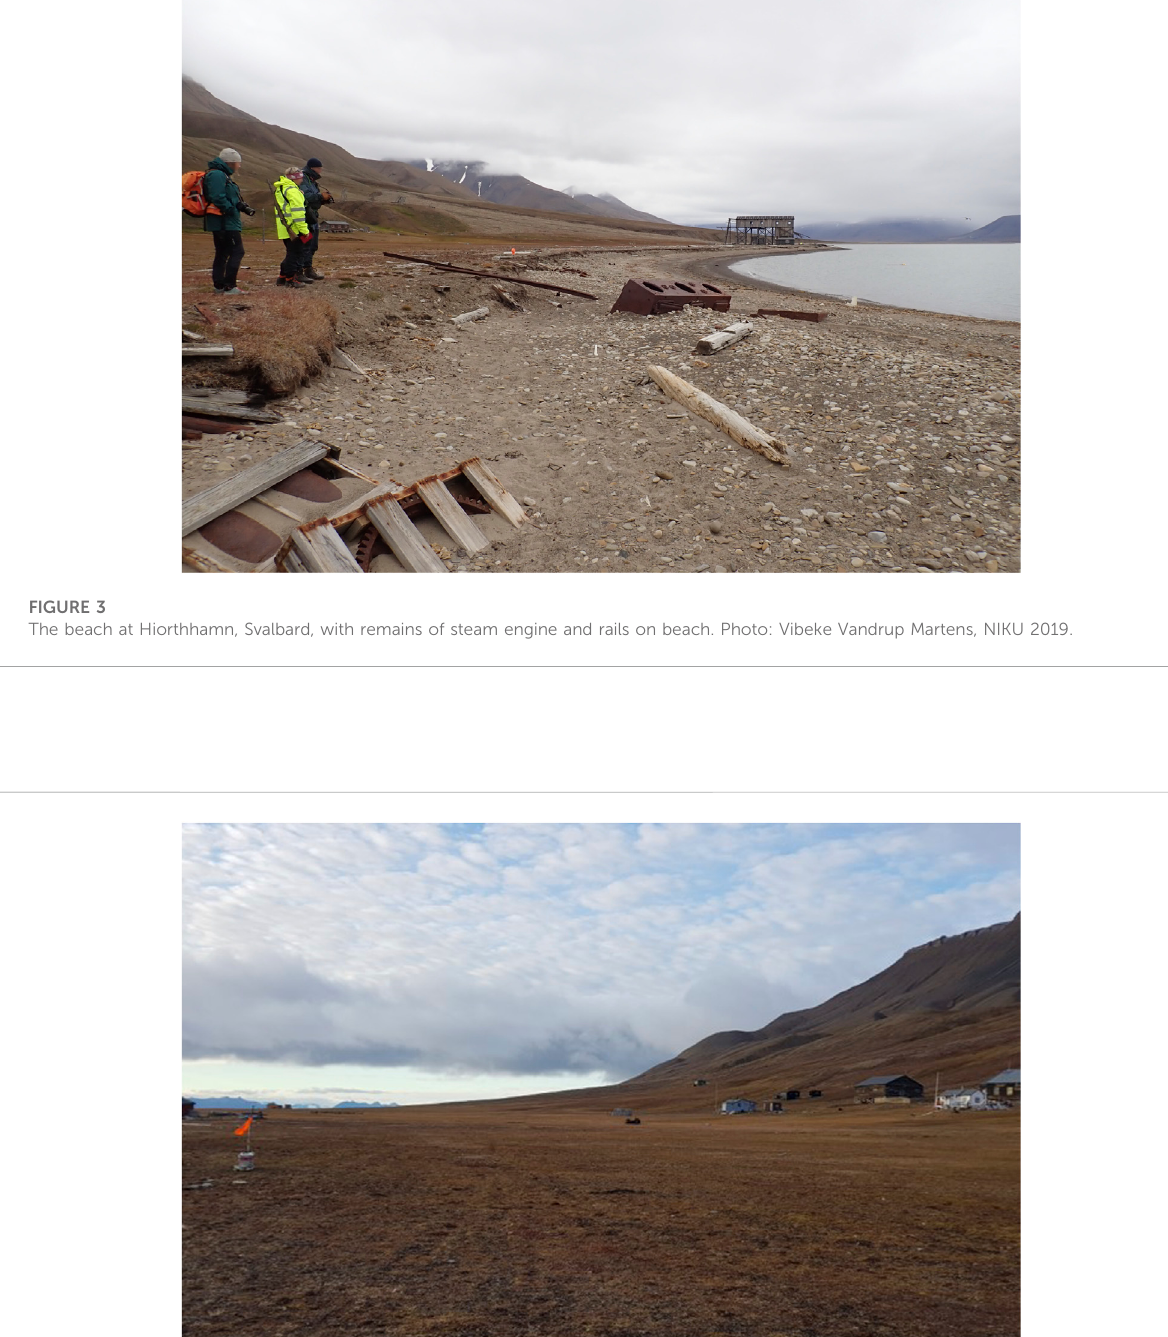
Frontiers in Earth